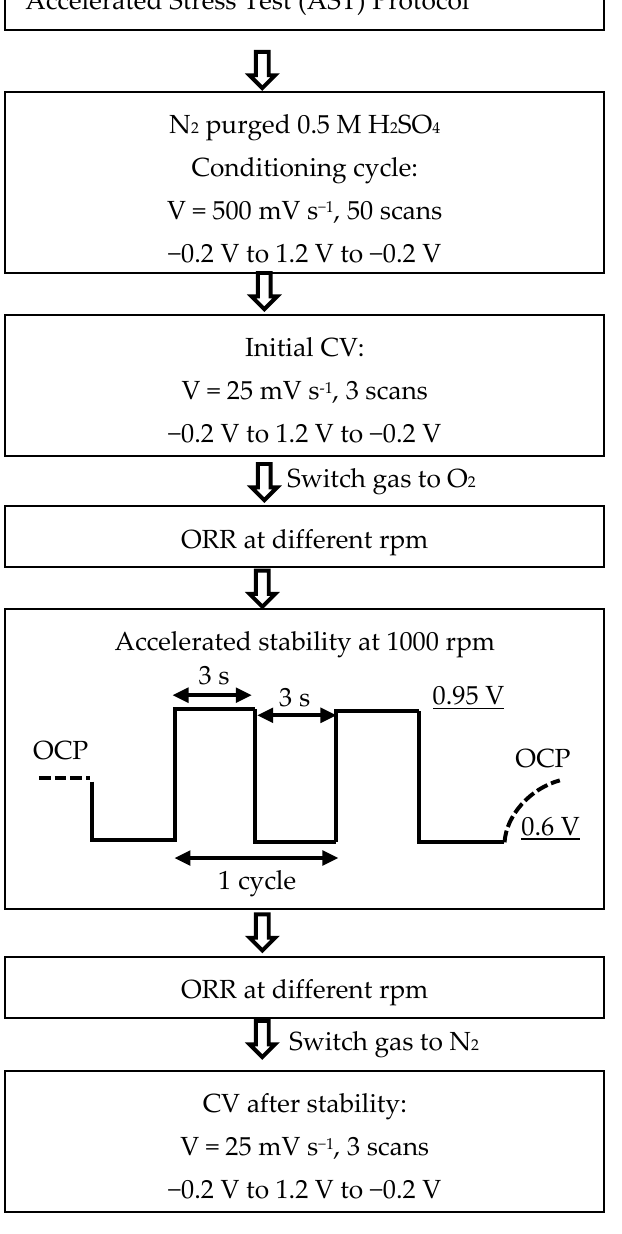
Figure 1. AST protocol scheme for PEM fuel cell catalyst evaluation.